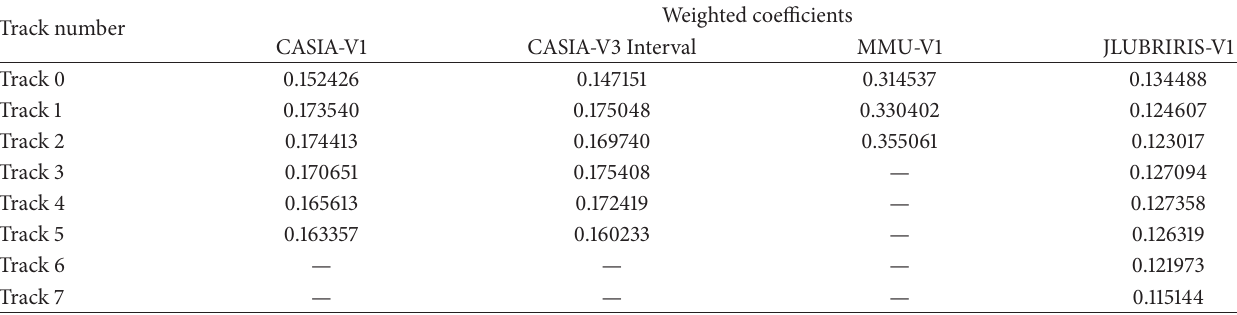
Table 7: Weighted coefficients of different